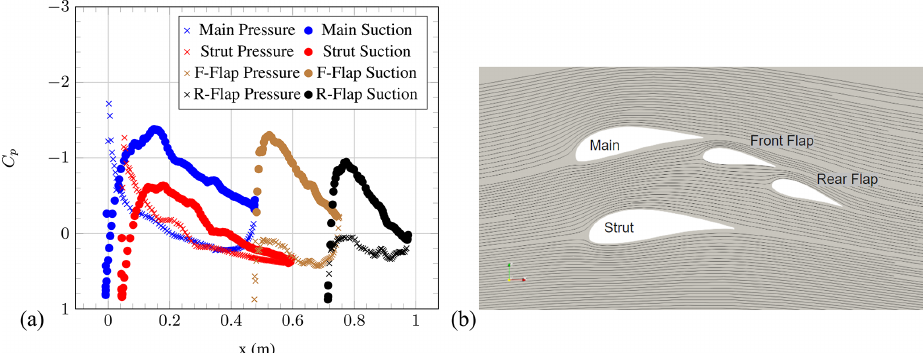
Figure 9. (a) Pressure coefficient of the individual element airfoils and (b) streamlines at AoA = 10 ◦ (OpenFOAM